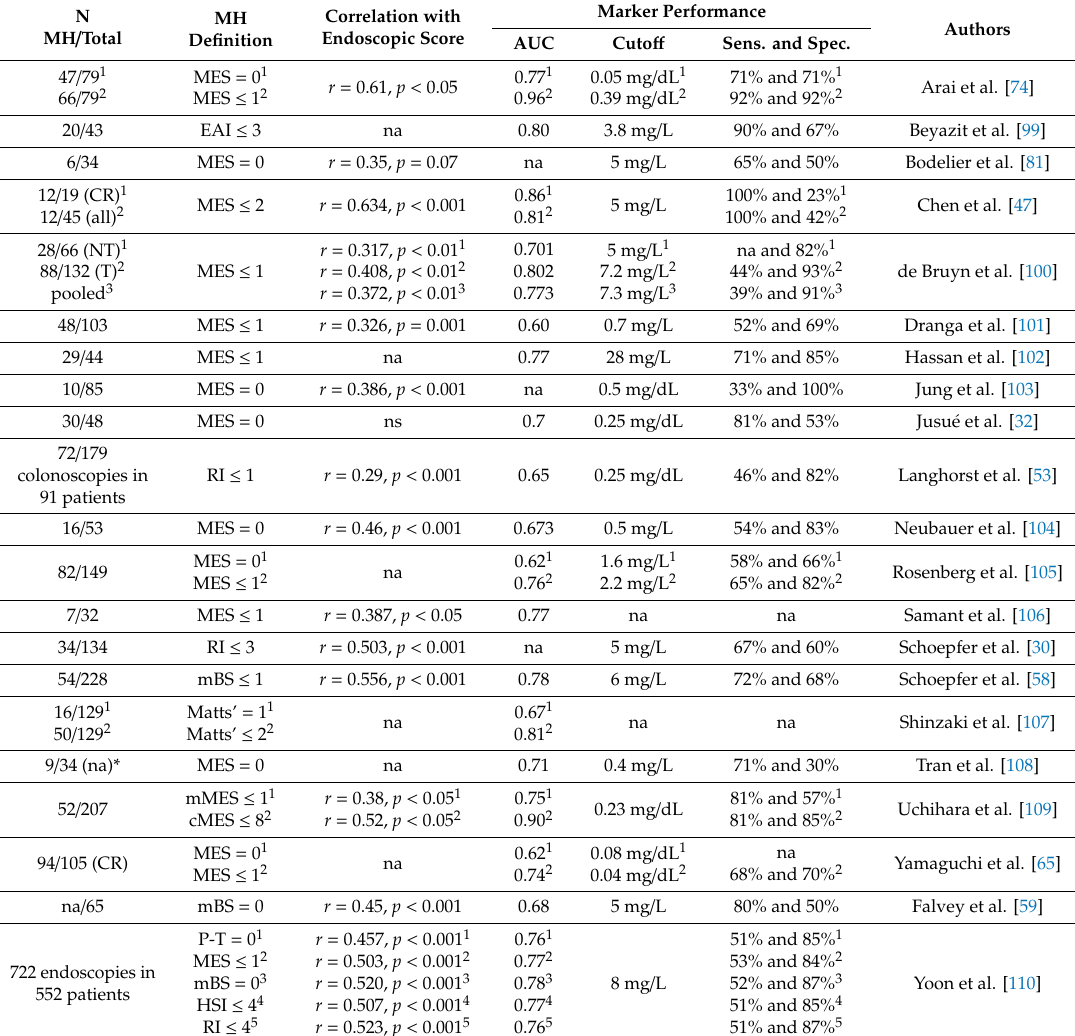
Table 6. Diagnostic performance of C-reactive protein in MH detection for ulcerative